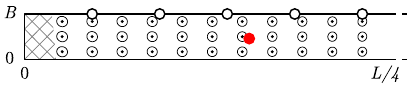
Figure 21. Representation of the random measurement error covariance matrix of the drone camera for a quarter of the bridge deck: 95% confidence regions (lines) for different locations on the bridge deck (dots). The confidence regions are rescaled with a factor 3 around the true locations for illustration purposes. The hatched area represents the part of the bridge deck that is outside the FOV of the